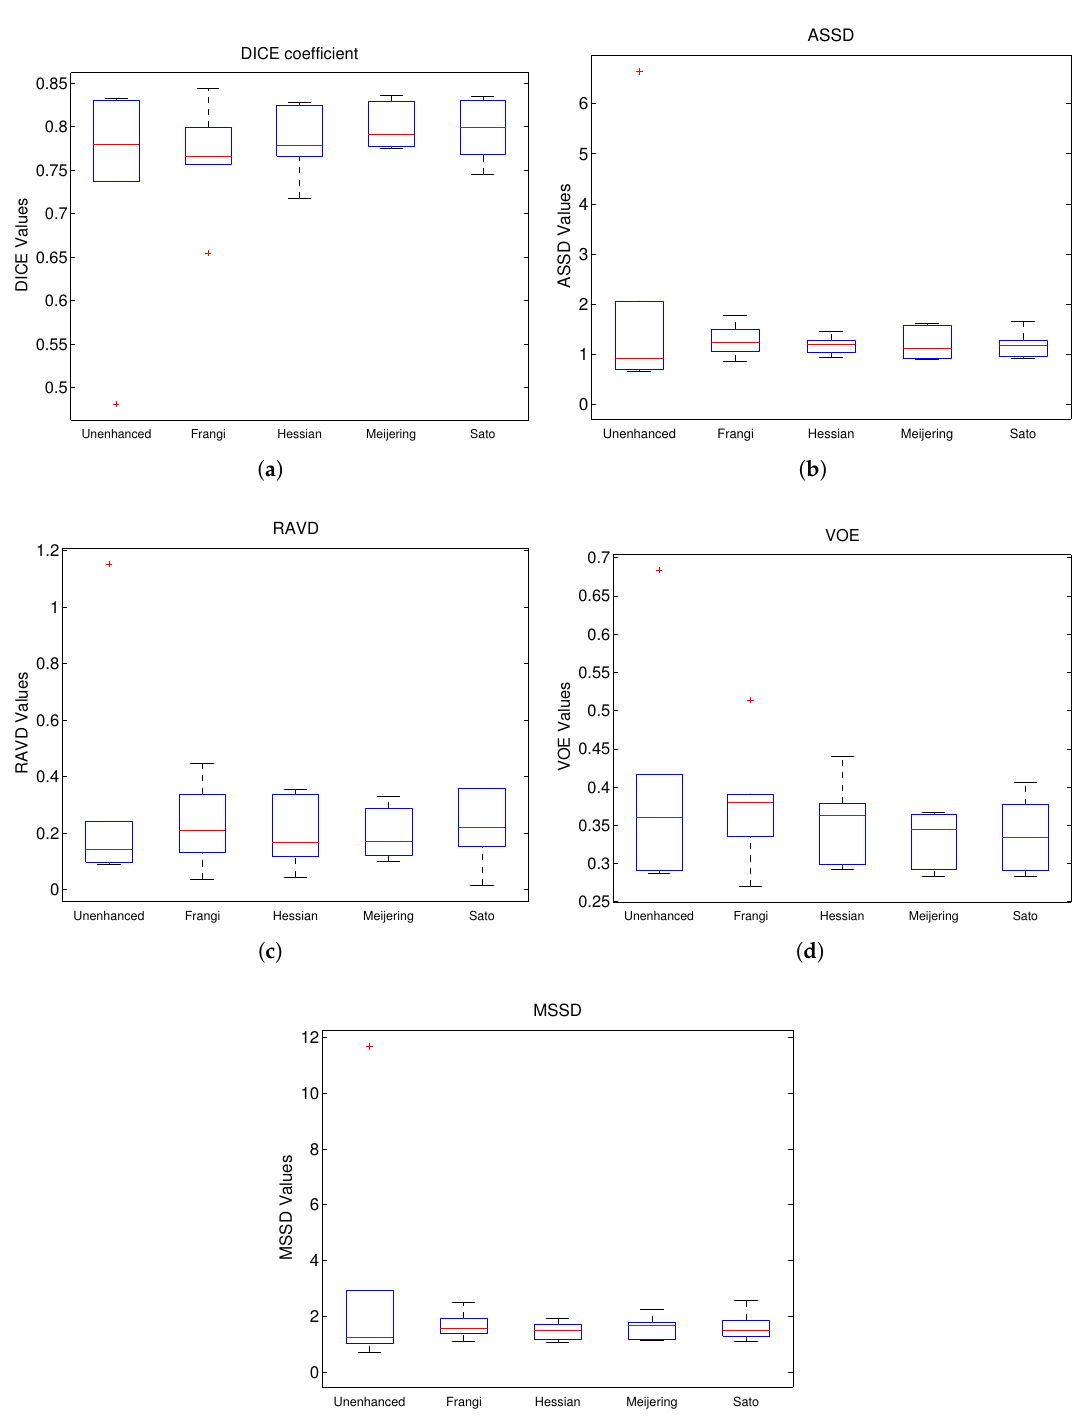
Figure 7. Comparison of segmentation for unenhanced and different filtered images (red + are outliers). ( a ) DICE; ( b ) ASSD; ( c ) RAVD; ( d ) VOE; ( e )